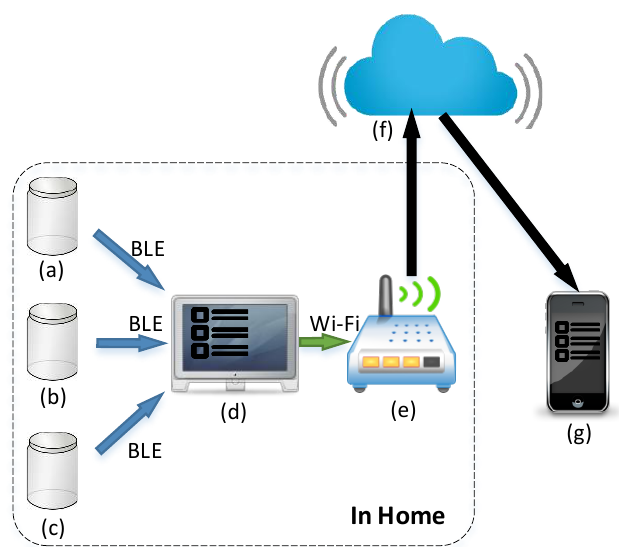
Figure 1. The architecture of the smart canister system. ( a – c ) are smart canisters with the electronic device placed in the caps. The canisters are connected wirelessly with the central hub ( d ) using BLE. The central hub displays the item quantities, connection status, and battery levels of each canister. The hub is connected with the home router ( e ) using Wi-Fi. The hub sends cloud message ( f ) using the Internet to the smartphone app ( g ) to sync the data between hub and smartphone. The items that are running below a threshold level are automatically added in the shopping list of ( d , g ).